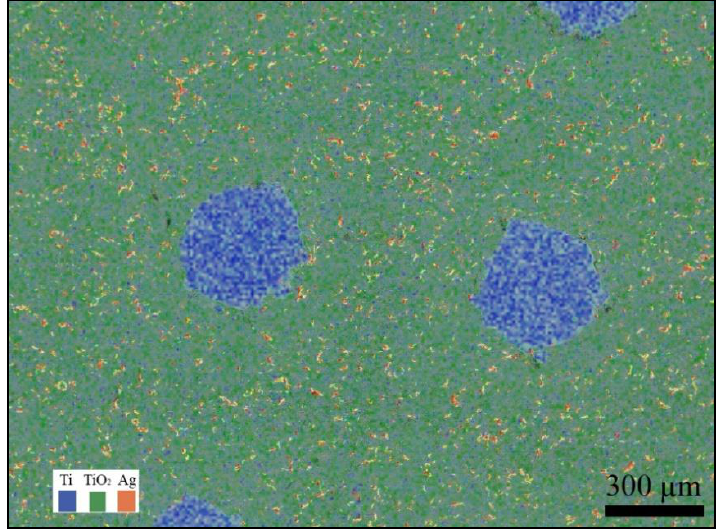
Figure 6. Energy dispersive spectroscopy (EDS) color mapping of TiO 2 –2.5% Ag embedded 1 mm cell size Ti6Al4V lattice structure.